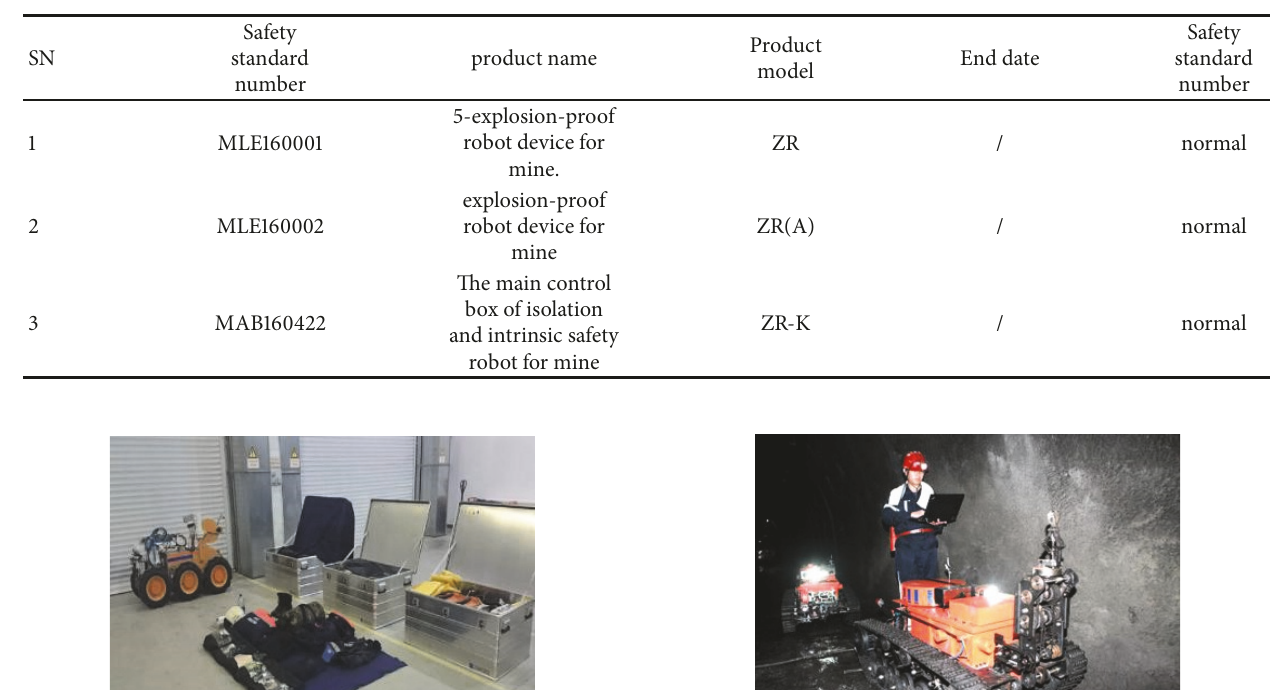
Table 1: Robot products of Changzhou Research and Development Center with safety certification.